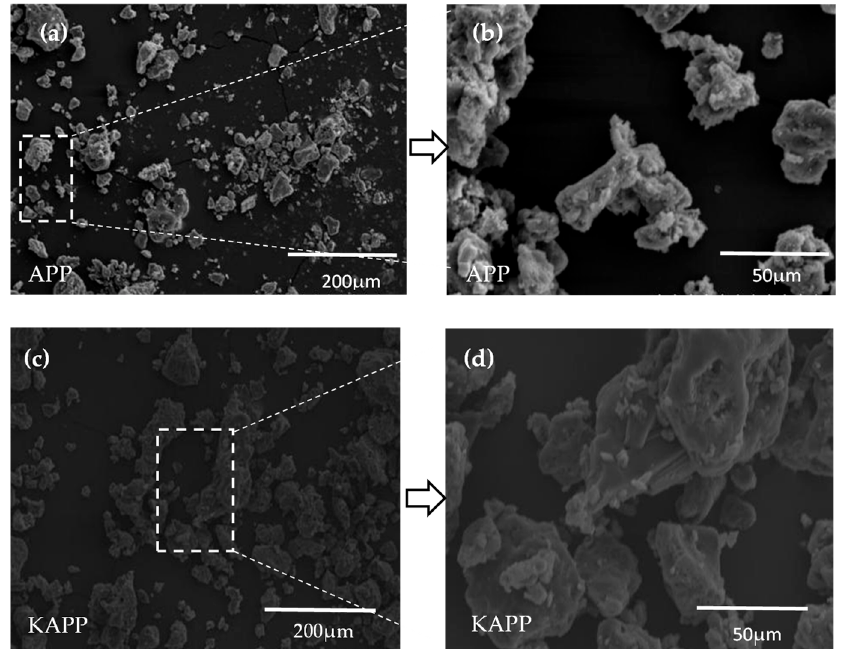
Figure 4. Scanning electron micrograph of APP and KAPP. ( a ) APP magnification × 200; ( b ) APP magnification × 800; ( c ) KAPP magnification × 200; ( d ) KAPP magnification × 800.